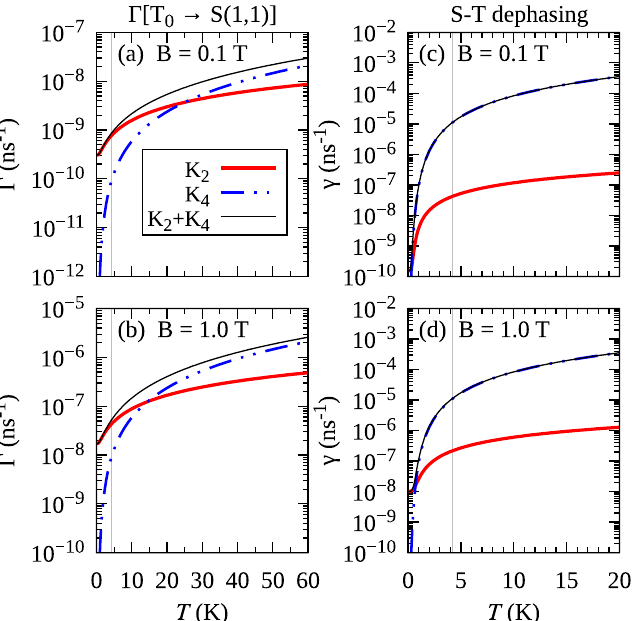
T S ( 1, 1 ) ( a , b ), and 0 [ → ] S ( 1, 1 ) T ρ density matrix element ( c , d ). The electric field 0 � | | � 14.87 kV/cm. The vertical lines denote T 4.2 K. Lines show the second- and = =